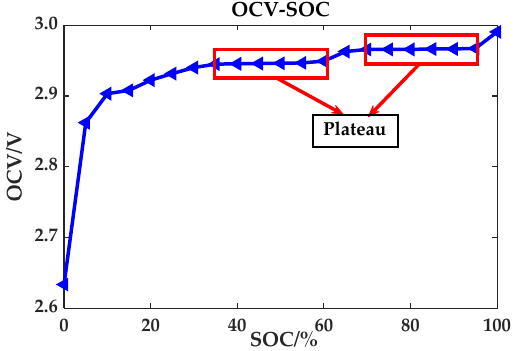
Figure 12. OCV–SOC at 25 °C and the plateau period curve.